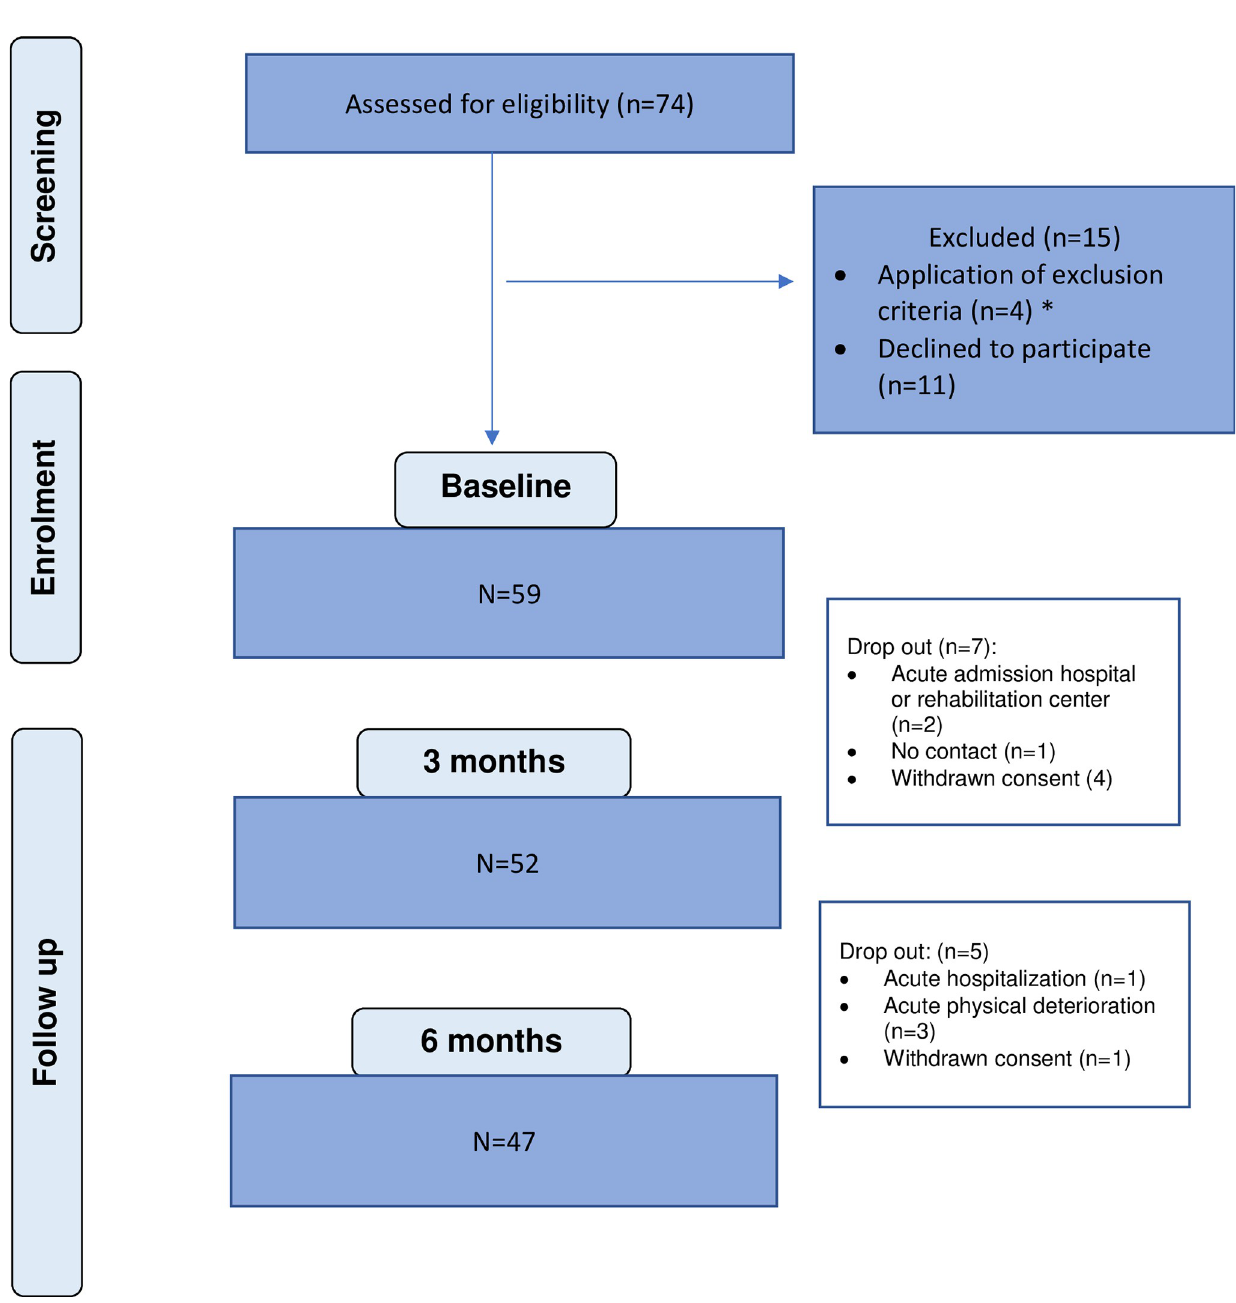
Fig 1. Consort flow diagram. * non-invasive ventilation (n = 1), cognitive impairment (n = 1), language barrier (n = 2).